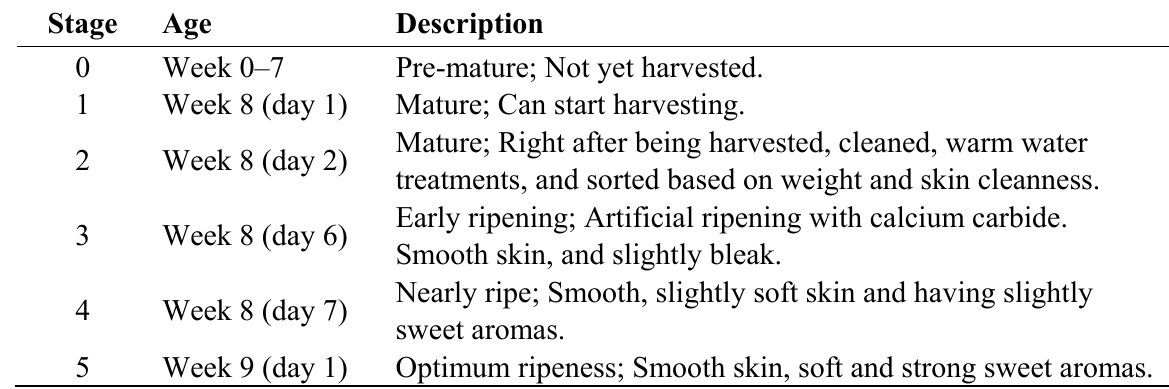
Table 1. Description of maturity stages and ripeness level of Harumanis mangoes.